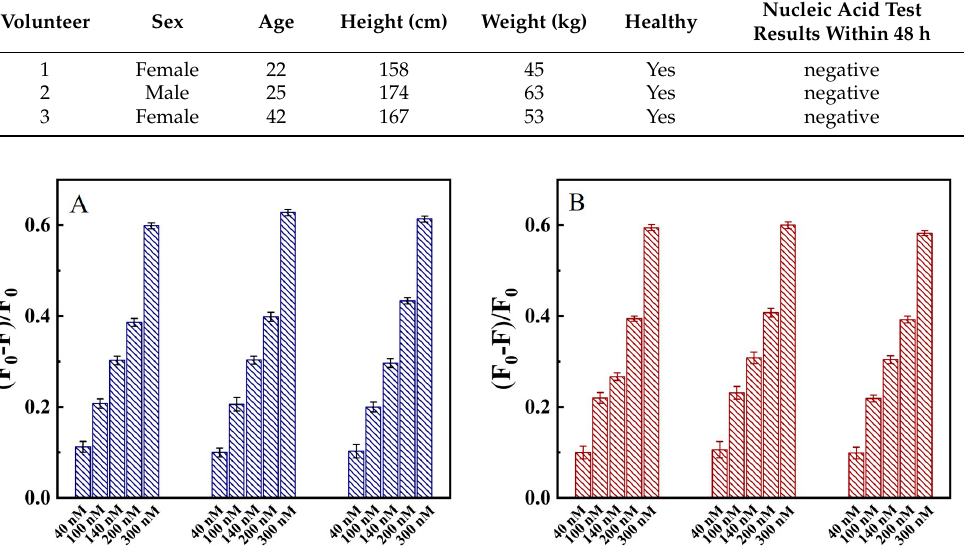
Table 1. Basic clinical characteristics of three volunteers.